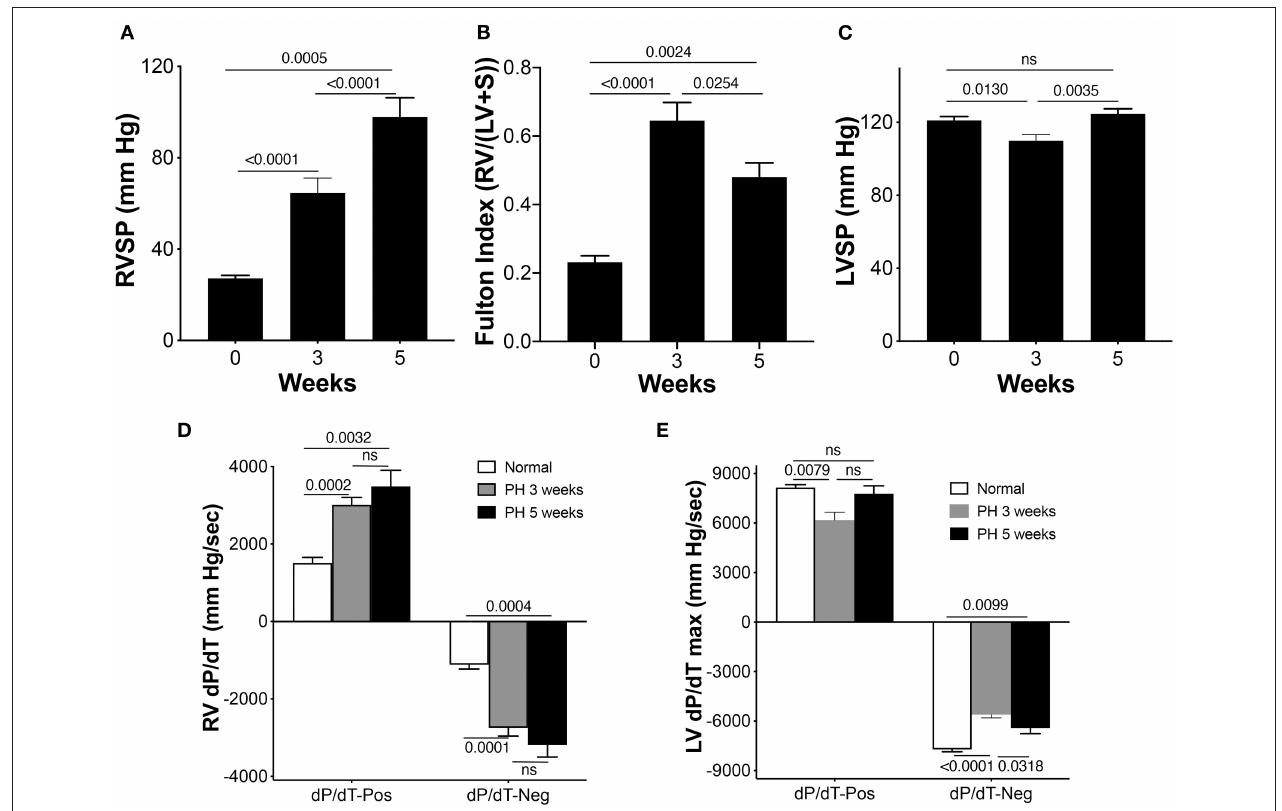
FIGURE 1 | Right ventricle (RV) pressures and electrocardiographic parameters in pulmonary arterial hypertension (PAH) rats. Pulmonary arterial hypertension was induced in rats as described in the Methods section. (A) The RV systolic pressure (RVSP) was measured in separate sets of control animals and animals at 3 and 5 weeks during the development of PAH, n = 10–17 animals/group. (B) Fulton Index ( n = 6–9 animals/group). (C) Left ventricle systolic pressure (LVSP), n = 10–17 animals/group. (D) Rates of rise and decline of the RV pressure in systole (above baseline) and in diastole (below baseline) (dP/dT) were recorded, n = 10–17 animals/group. (E) Rates of rise and decline of the LV pressure in systole (above baseline) and in diastole (below baseline) (dP/dT) were recorded, n = 9–17